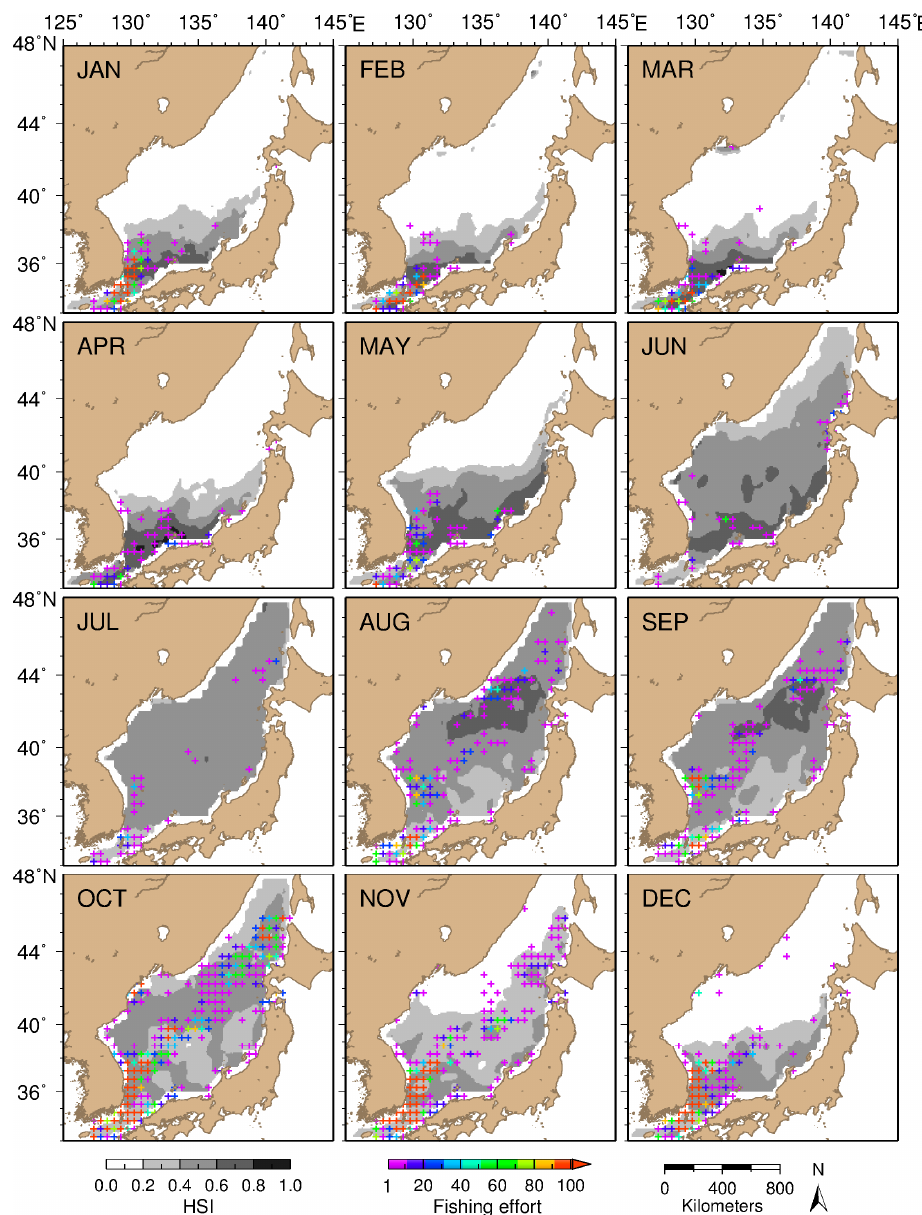
Figure 4. Monthly-averaged potential squid habitat in the Sea of Japan from multiple model simulations developed from January–December, 2010–2013. Overlain are the monthly gridded fishing efforts derived from night-time satellite images.